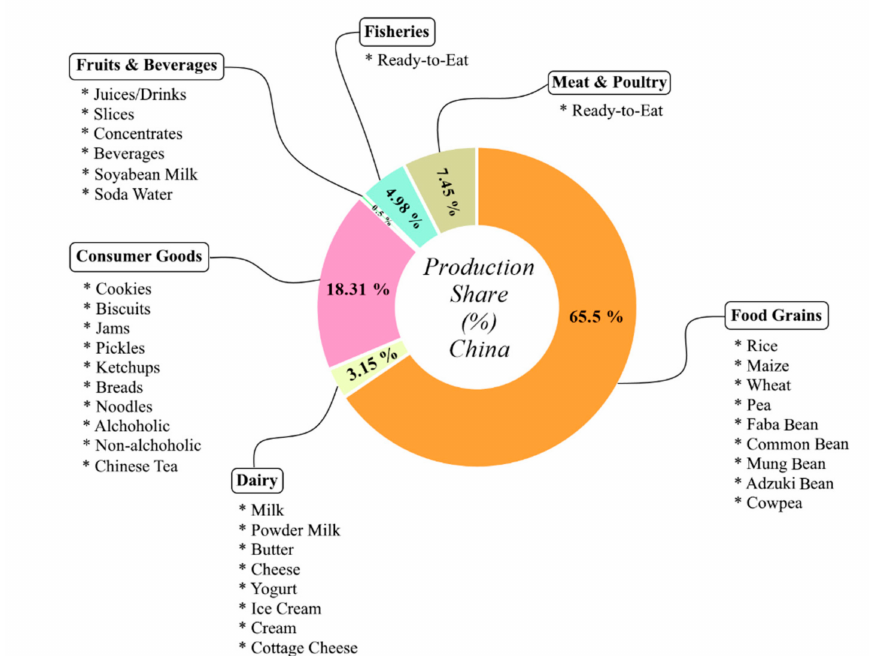
Figure 7. China’s food and beverage sub-sectors and estimated production share